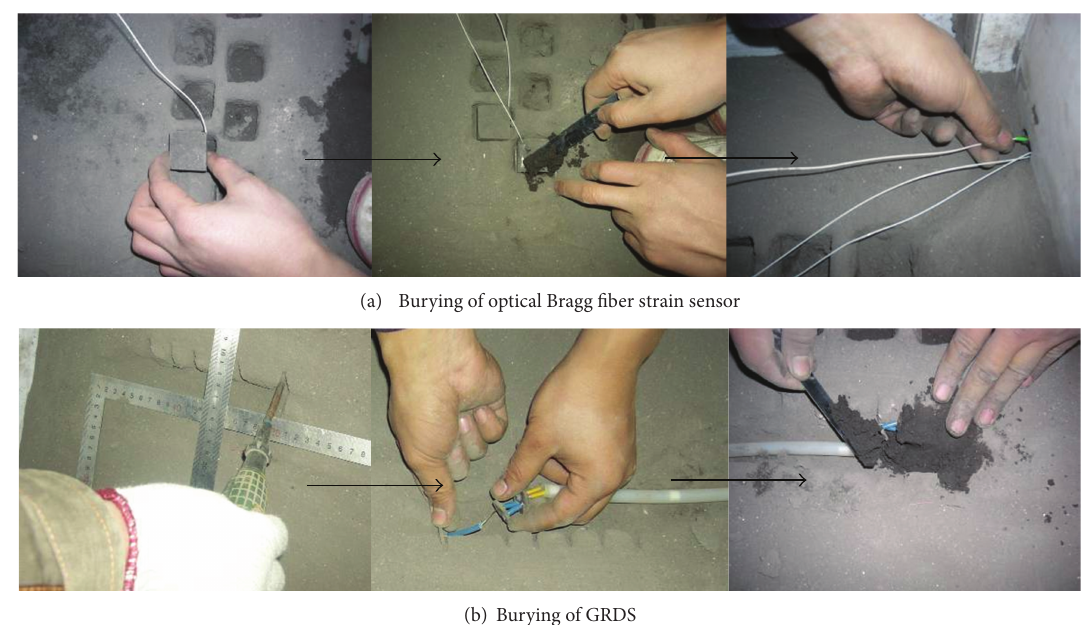
Figure 10: Burying procedure of the optical measurement sensor. The sensor is Fiber Optical Bragg grating sensor, where the precision is 10 −3 𝜇𝜀 . The spacing between those sensors is 1cm.